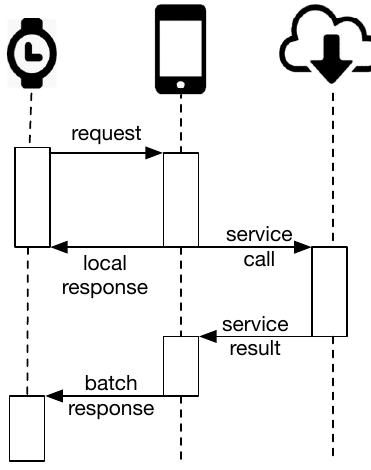
Figure 3. Communicating data between the phone or cloud and the smartwatch. If the data come from the phone, the response is immediately sent to the smartwatch. Otherwise, if there is a need for an external service call via the cloud, the Sensor Reader on the watch performs a batch call without waiting for the response. When the response is ready, it will be delivered to the smartwatch via the